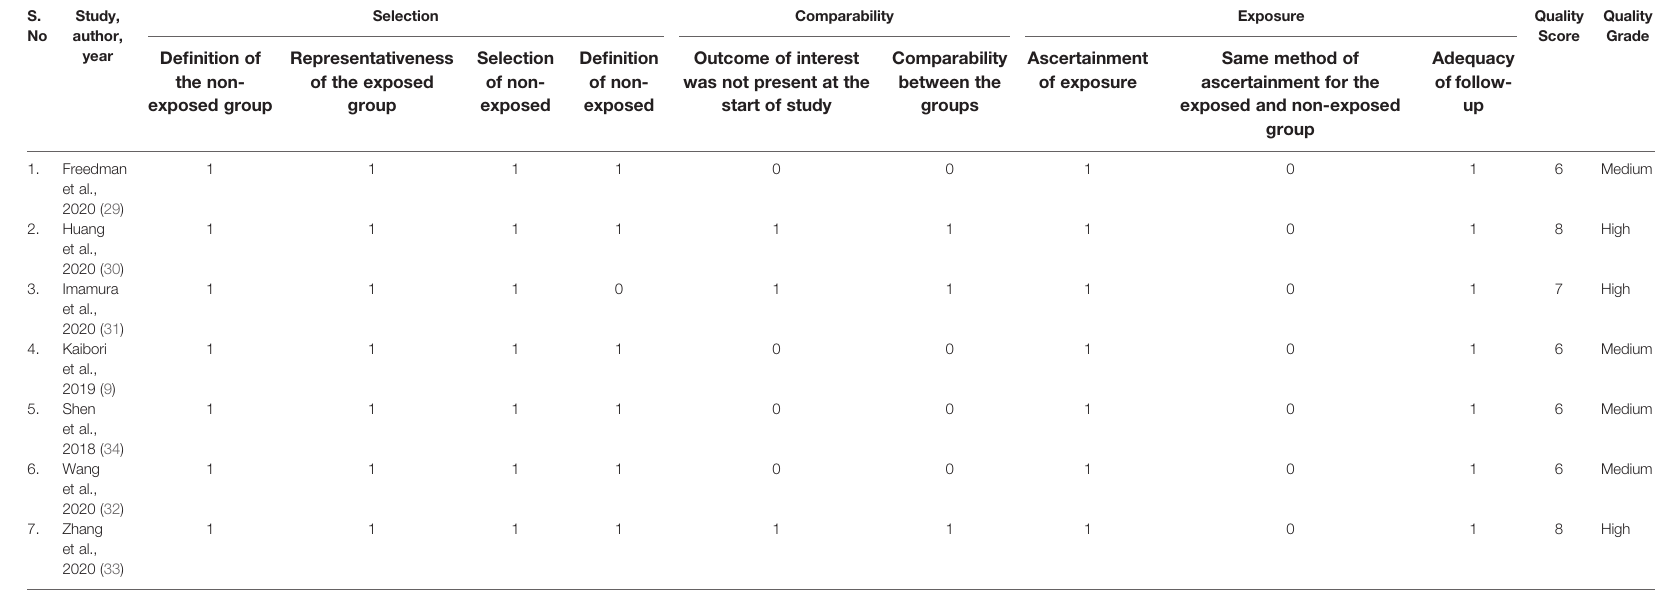
TABLE 3 | Quality assessment of the included studies in the systematic review using the Newcastle – Ottawa Scale.